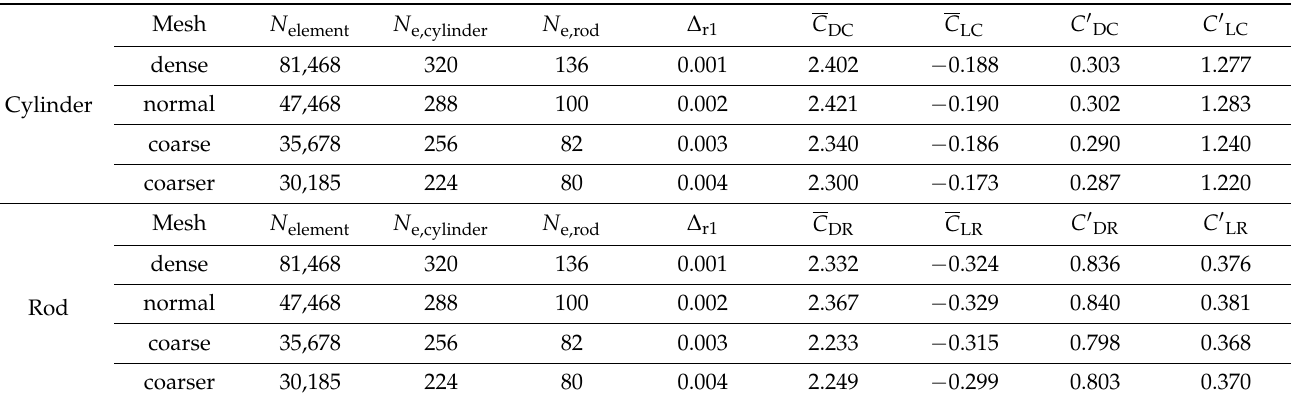
Table 1. Statistical values of the drag and lift coefficients in the mesh dependency study for β = 90 ◦ and α = 7.